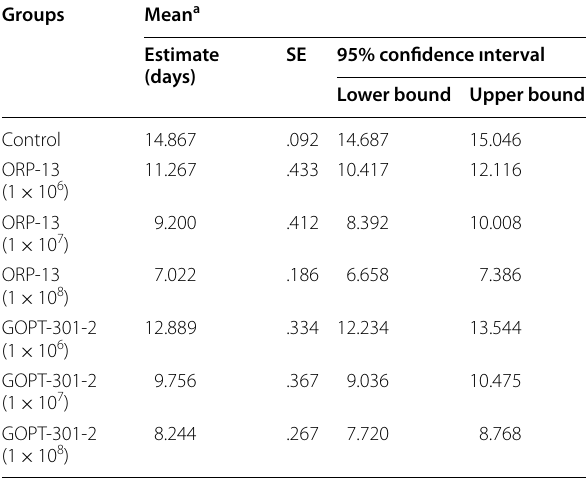
Table 3 Mean lifespan of Malacosoma neustria larvae